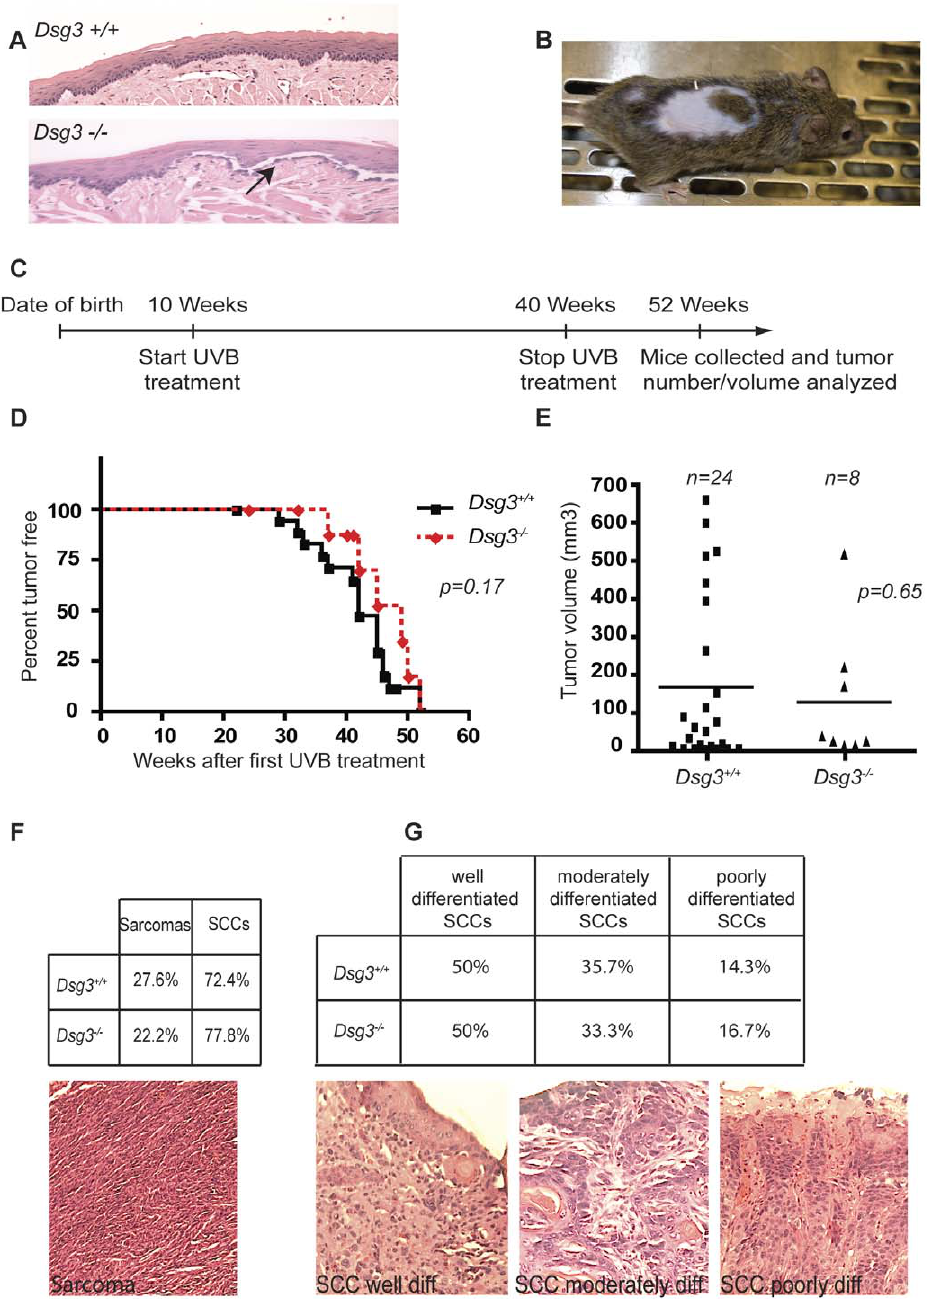
Figure 3. Dsg3 does not affect tumor incidence, tumor volume, or tumor grade in UVB-induced skin carcinogenesis. A) Representative hematoxylin and eosin (H and E)-stained sections of Dsg3 + / + and Dsg3 2 / 2 mouse tongue epithelium. Arrow indicates the presence of blisters in the Dsg3 2 / 2 tongue epithelium. B) Photograph of an adult Dsg3 2 / 2 mouse, showing hair loss typical of Dsg3 deficiency. C) Schematic diagram illustrating the experimental design and timeline for the UVB-induced SCC model used. D) Kaplan-Meier analysis of tumor-free survival of Dsg3 + / + and Dsg3 2 / 2 mice subjected to chronic UVB treatment. p=0.17, log rank test. E) Graph indicating the tumor volume in each Dsg3 + / + (24 tumors collected) and Dsg3 2 / 2 (8 tumors collected) mouse after 52 weeks of UVB treatment. p=0.65, Student’s t-test. F) Histological analysis by H and E staining, showing the percentages of sarcomas and squamous cell carcinomas among the tumors observed in mice of each genotype. A representative H and E-stained sarcoma is shown. G) Analysis of the percentages of SCCs of different grades in Dsg3 2 / 2 and Dsg3 + / + mice. Photographs show representative H and E-stained SCCs with different levels of differentiation (highly, moderately, and poorly differentiated). doi:10.1371/journal.pone.0050024.g003 into the flanks of immunocompromised Scid mice and assessing transformed Dsg3 + / 2 keratinocytes developed tumors, whereas tumor growth. After five weeks, at which time mice were sacrificed only 80% of the mice injected with transformed Dsg3 2 / 2 keratinocytes developed tumors (data not shown). While tumor and tumor volume was calculated (Fig. 2C), all mice injected with